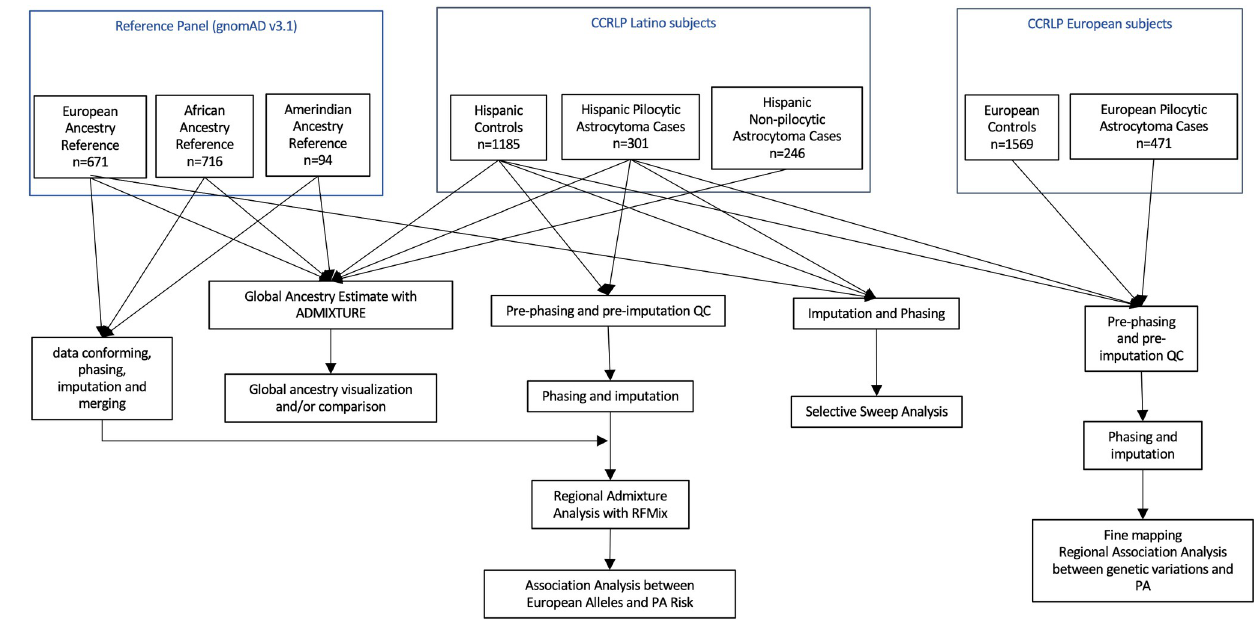
Fig 1. Flowchart for data processing and